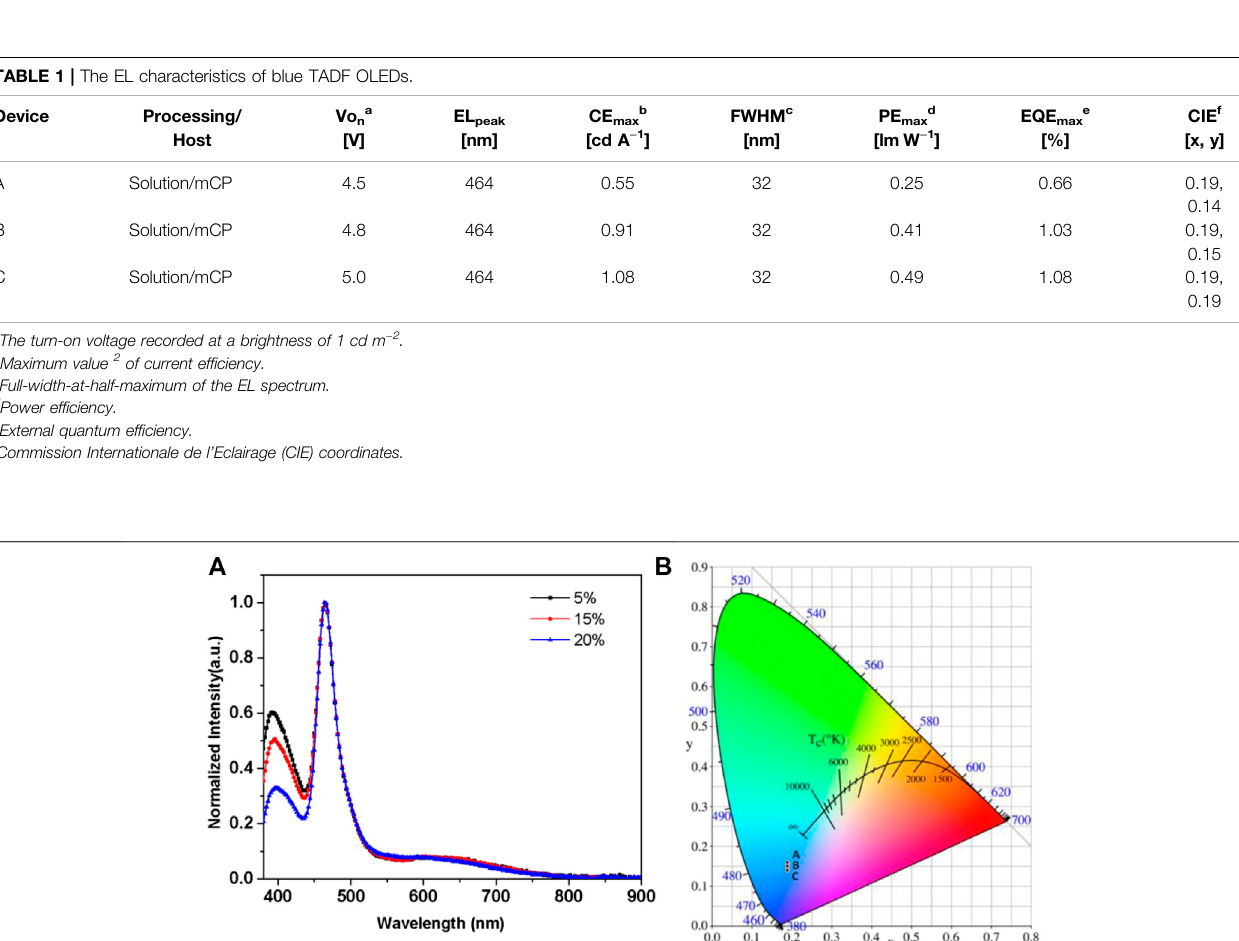
FIGURE 2 | (A) Current density-voltage-luminance and (B) current ef fi ciency-luminance-power ef fi ciency characteristics of the devices.